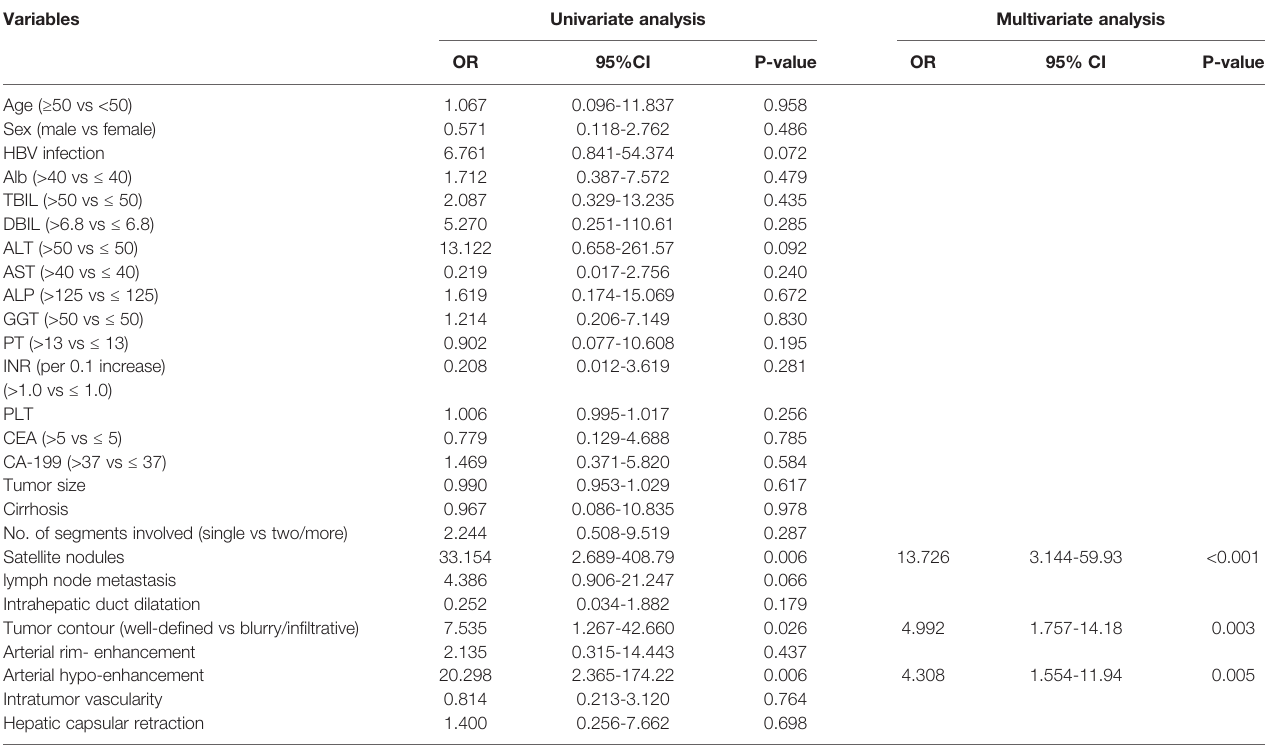
TABLE 3 | Univariate and multivariate analyses of risk factors for